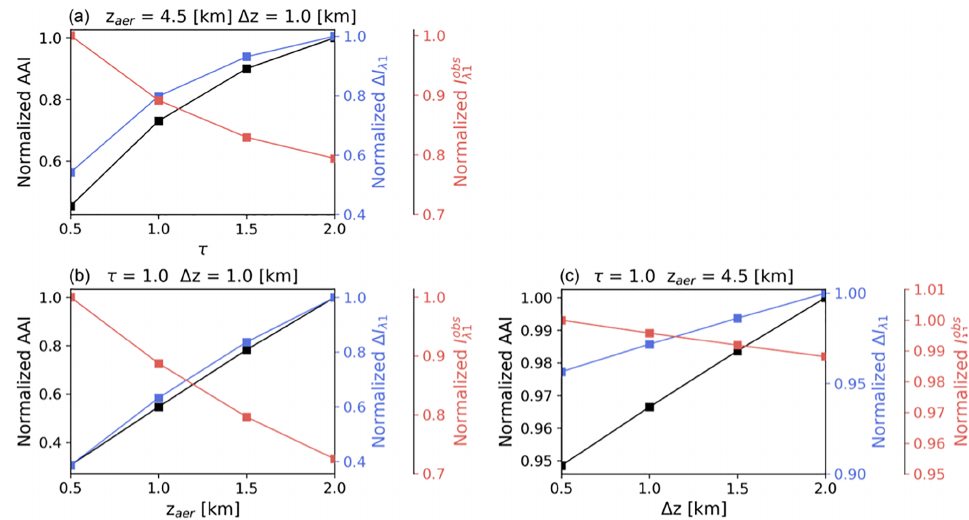
Figure 4. AAI sensitivity to macrophysical parameters (a) τ at 550nm, (b) z aer and (c) (cid:49)z .